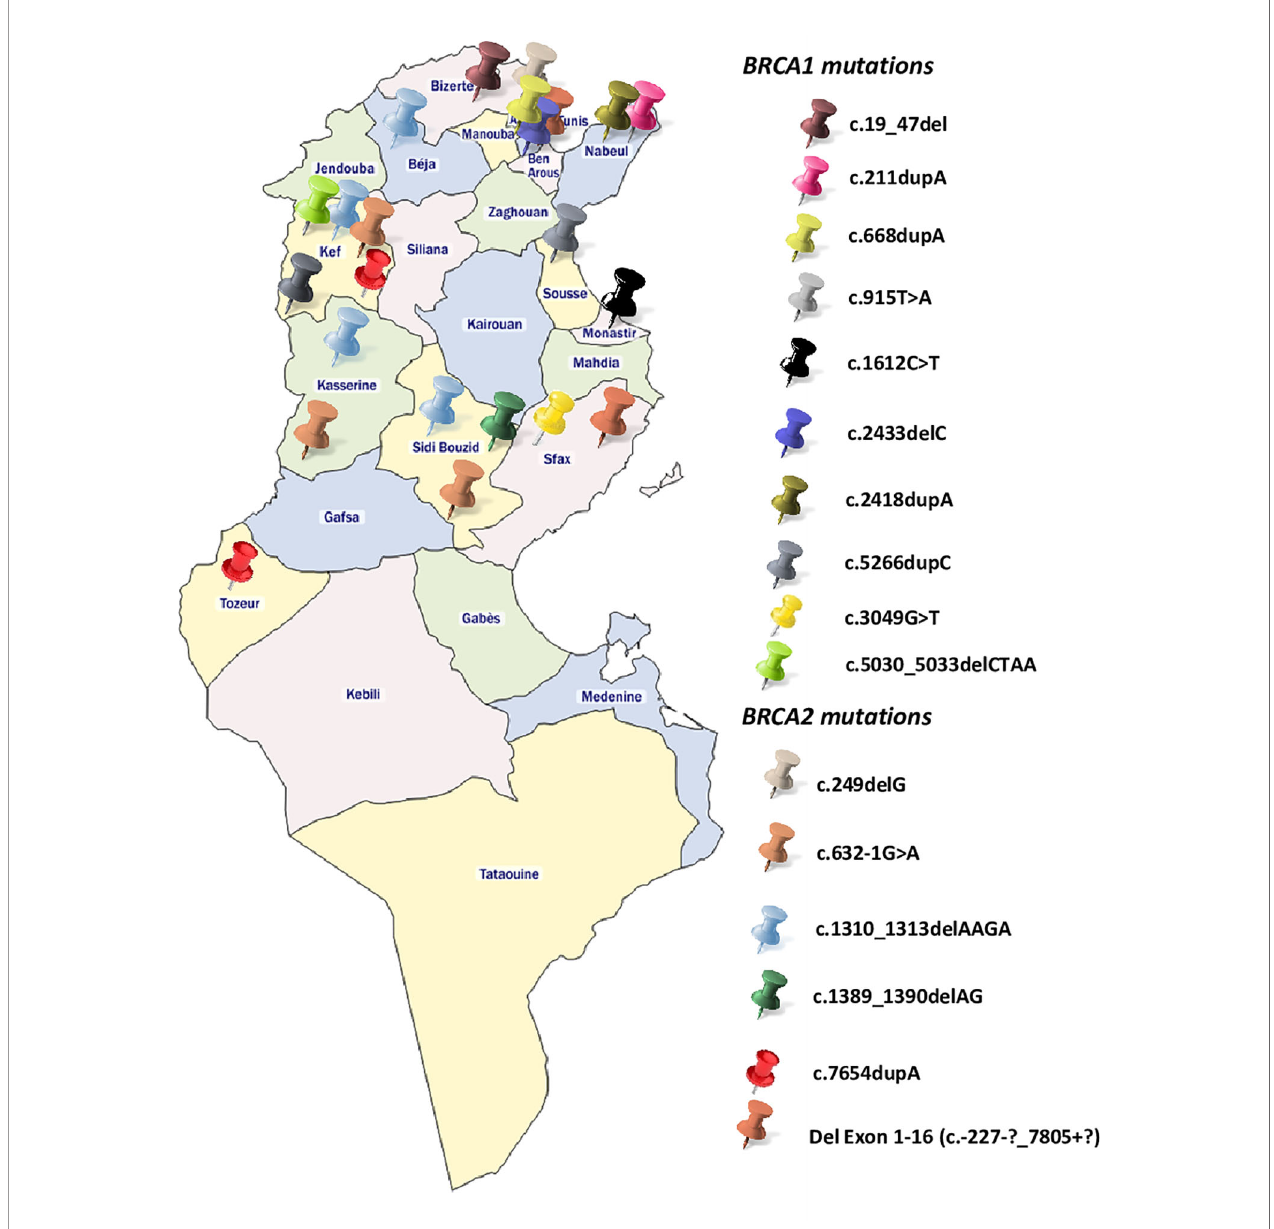
FIGURE 2 | Geographical distribution of the identi fi ed BRCA1 and BRCA2